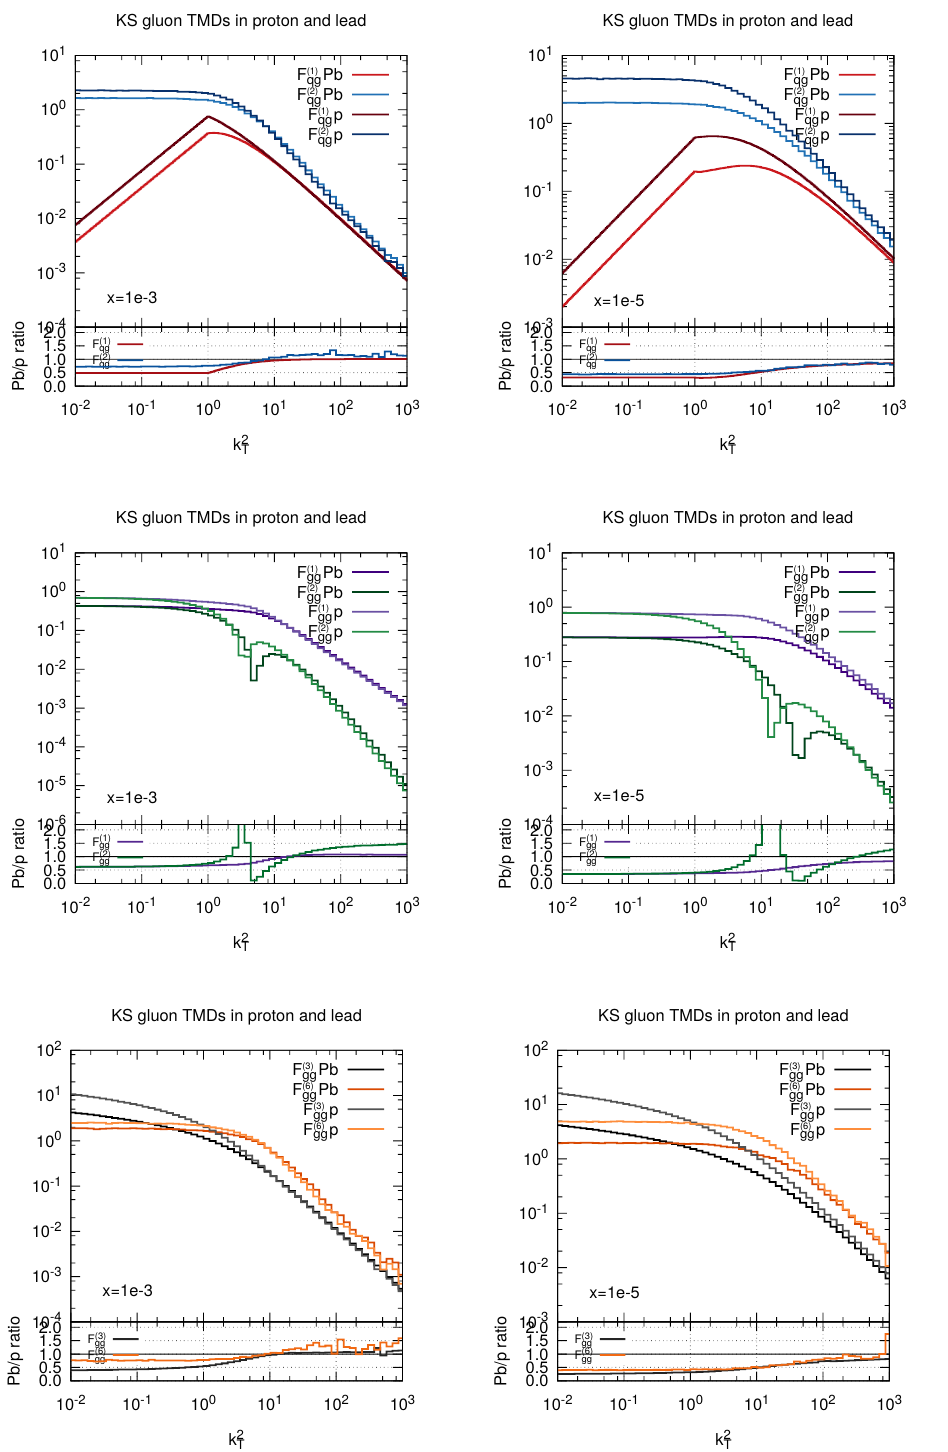
Figure 2 . Comparison of KS TMDs for p and Pb and the Pb/p ratios for x = 0 : 001 (left column) and x = 0 : 00001 (right